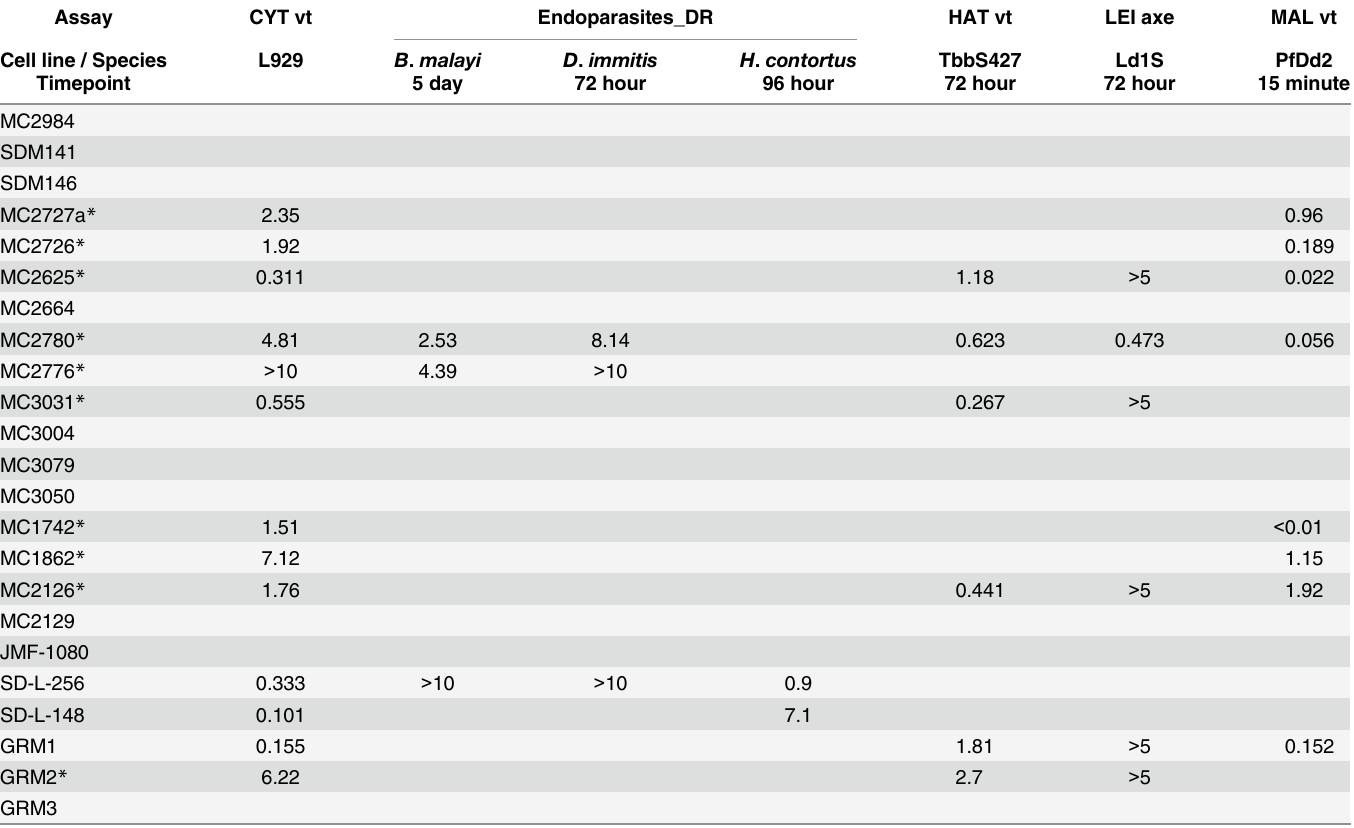
* compounds with lower activity in at least one parasite species compared to